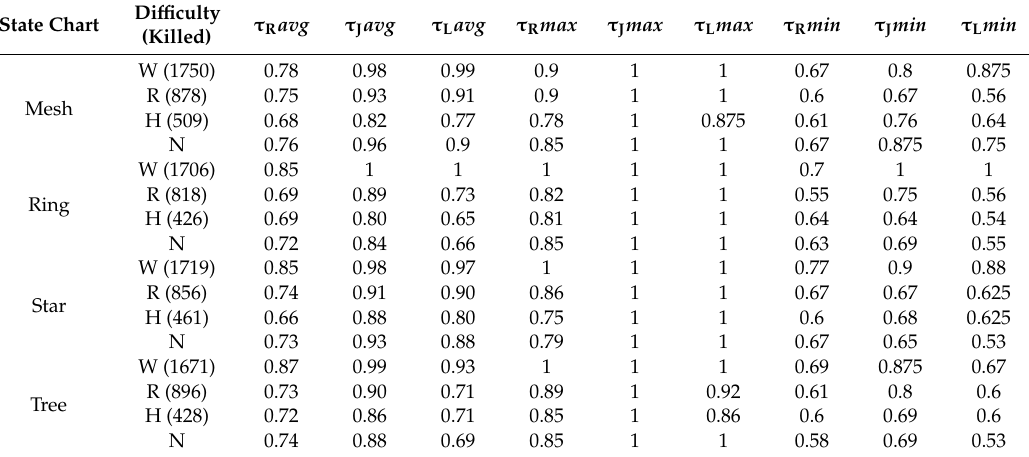
Table 4. Summary of experimental